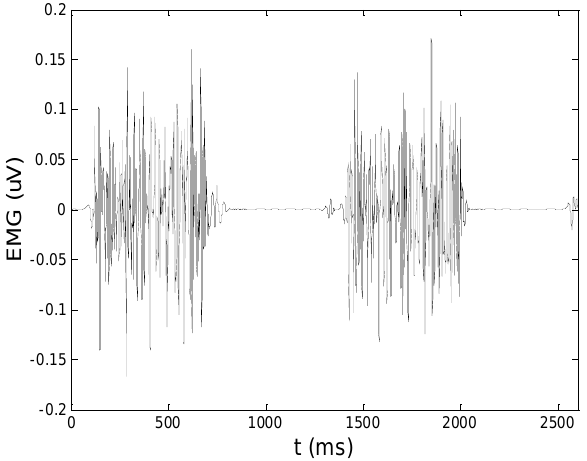
Figure 11. Simulated artificial EMG denoised by Daubechies5 wavelet and implementation of the soft sqtwolog threshold.